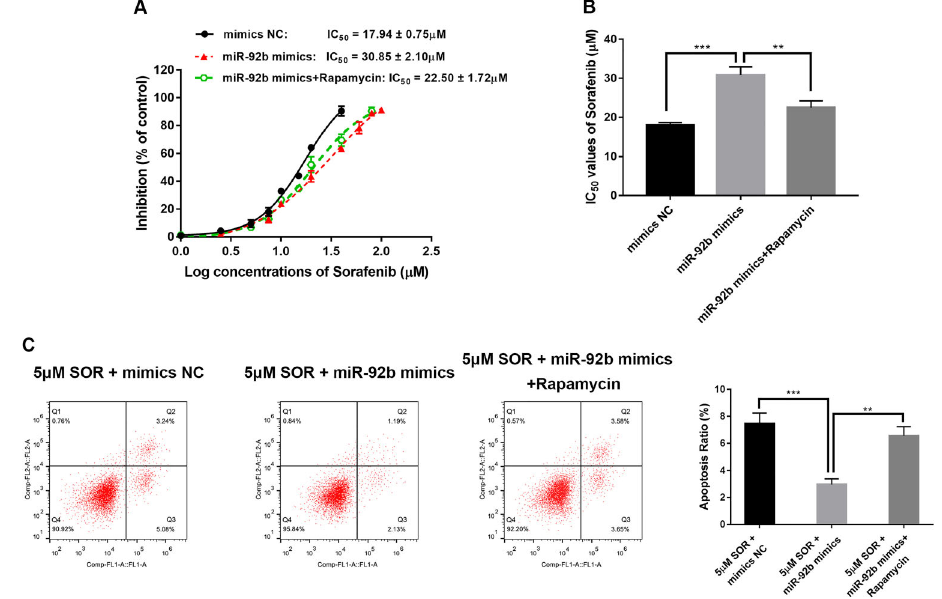
Figure 6. Inhibition of p-mTOR attenuated the sorafenib resistance of HepG2/SOR cells induced by miR-92b. A , Rates of inhibition and ( B ) half maximal inhibitory concentration (IC 50 ) values of sorafenib in HepG2/SOR cells transfected with mimics negative control (NC), miR-92b mimics, or miR-92b mimics + rapamycin. C , Flow cytometry was conducted to measure apoptosis of HepG2/SOR cells transfected with mimics NC, miR-92b mimics, or miR-92b mimics + rapamycin. Data are reported as means ± SD. **P o 0.01, ***P o 0.001